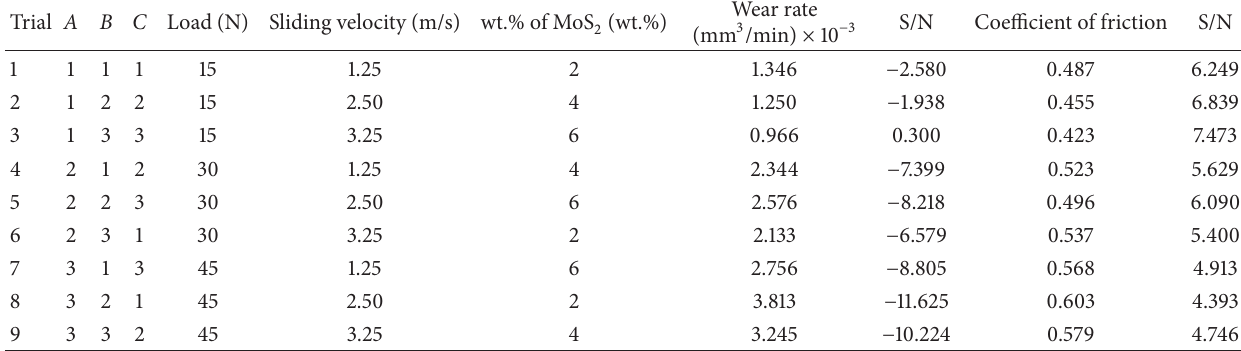
Table 8: Experimental results for Al6061/12wt.% Al 2 O 3 /MoS 2 of wear study.